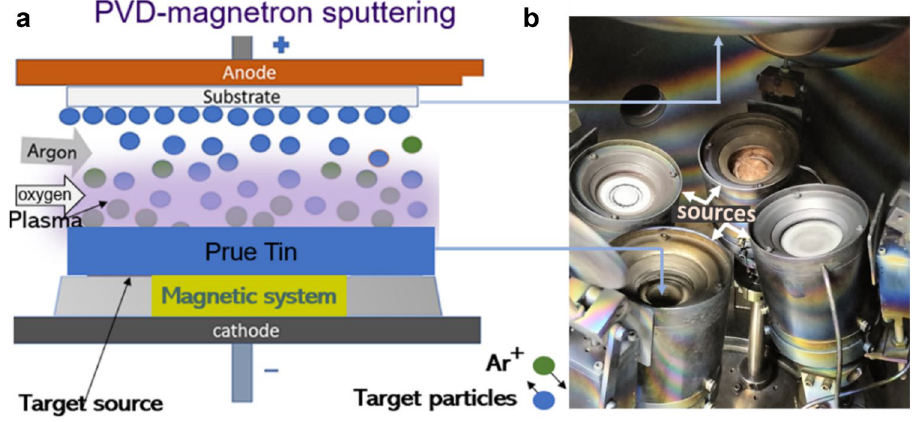
Fig. 3 a Magnetron sputtering process and b the internal view of the